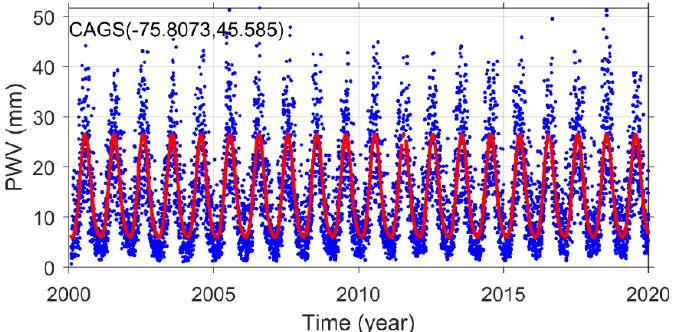
Figure A2. PWV time series (blue dots) and its fitting (red line) from the GNSS station PTBB.